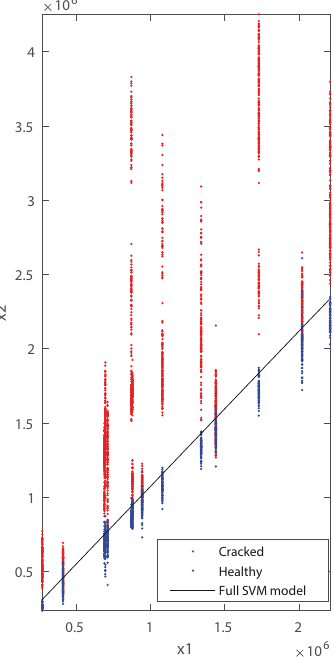
Figure 9. x 1 (V 2 /s) vs. x 2 in (V 2 /s) for wheelset 1 (WS1), WS2, WS3, and WS4; the healthy condition is represented in blue and the cracked condition in red. The line represents the full linear SVM model that best separates the data corresponding to the healthy and cracked